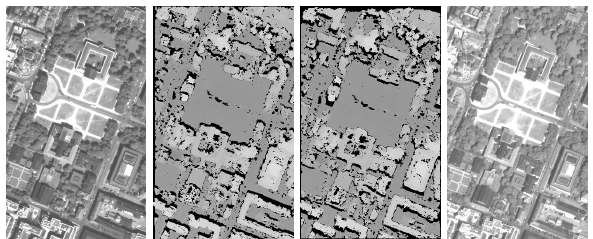
Figure 1. First pan image, height map fitting on first pan image, height map fitting on second pan image, second pan image (l.t.r.), 300 m × 500 m each (most left) and the second height map fits exactly on the second panchromatic image (most right).